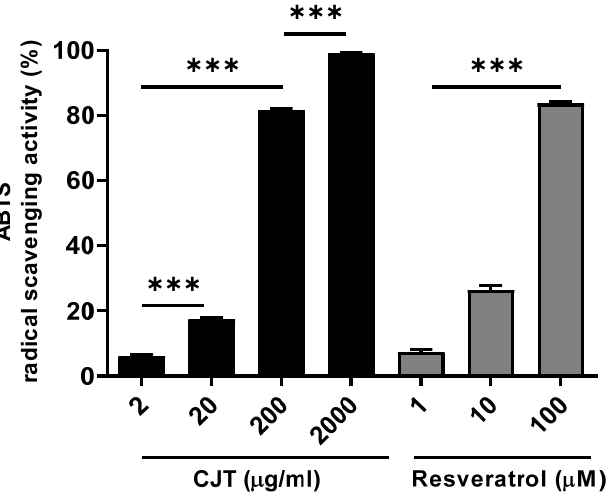
Figure 3. CJRE showed a strong antioxidative activity with dose-dependent manner. ABTS assay indicates that CJRE has a strong antioxidative effect. Resveratrol was used as the positive control. *** p < 0.0001.